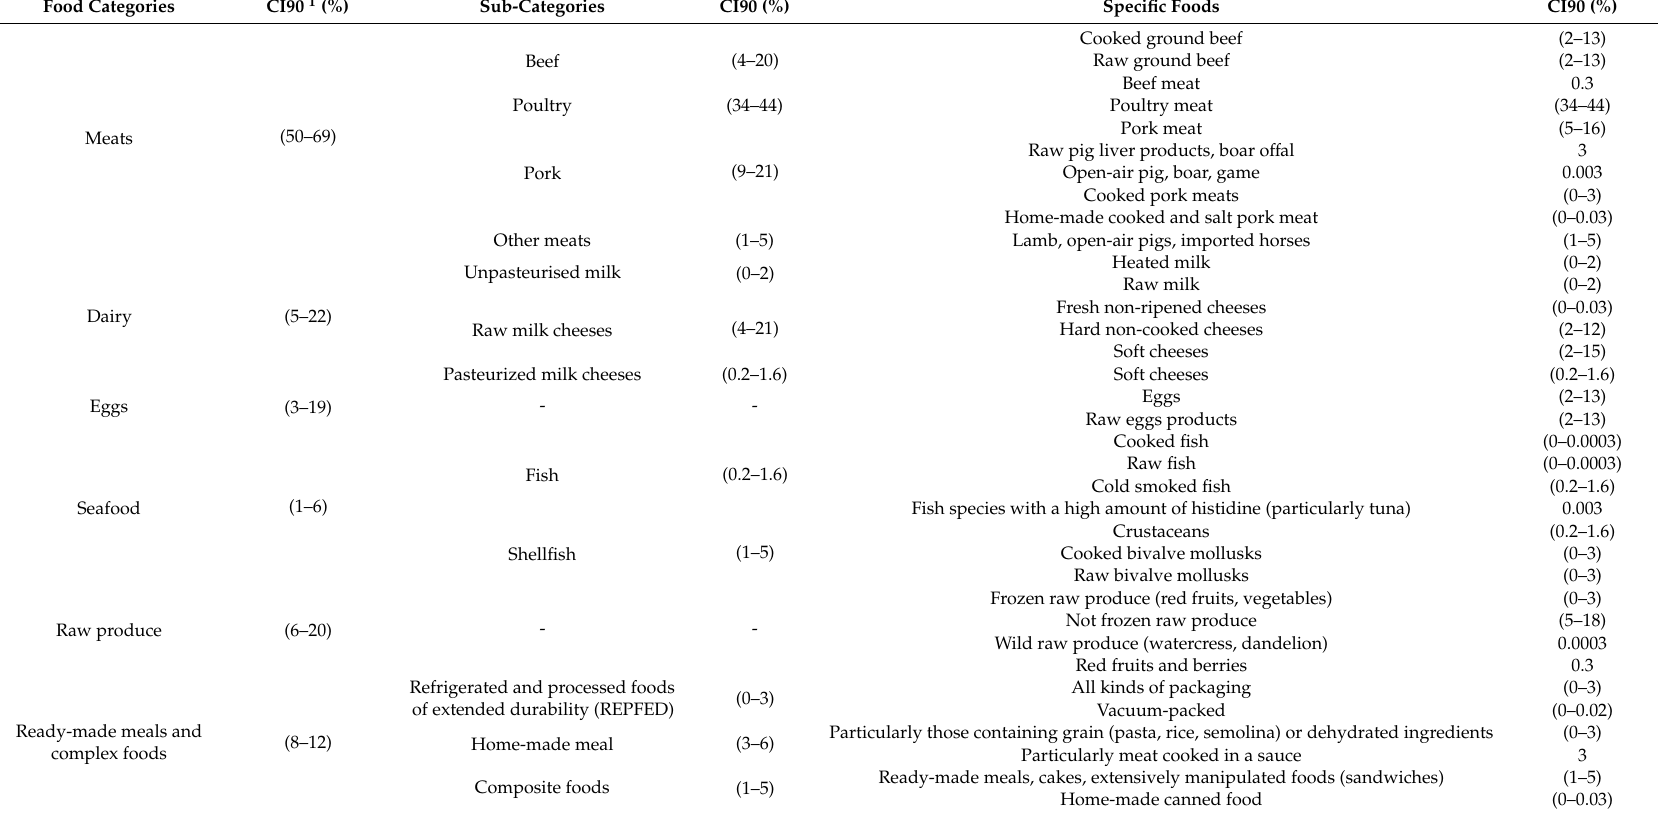
Table 4. Attribution of foodborne disease burden (FBDB) to